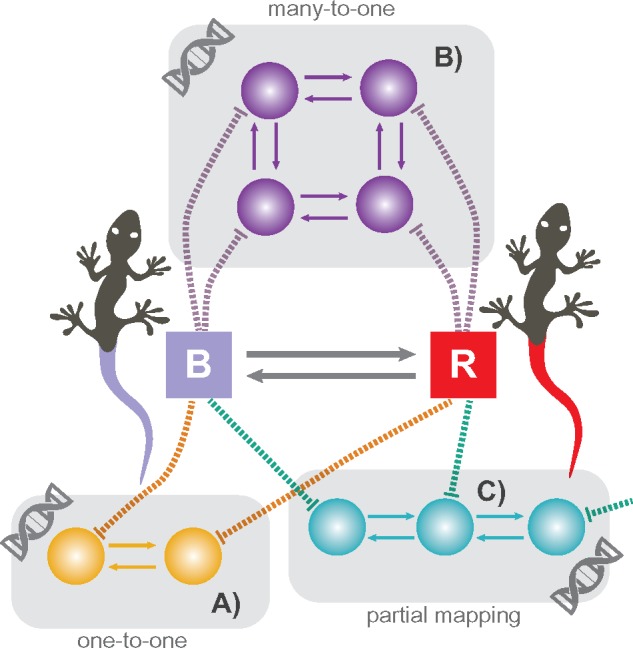
GRN-to-phenotype mapping. The tail color trait comprises two states: blue and red (shown with rectangles “B” and “R”, respectively). The states of hypothetical GRN modules that produce the tail color trait are shown with spheres. a) One-to-one mapping. b) Many-to-one mapping. c) Partial mapping.